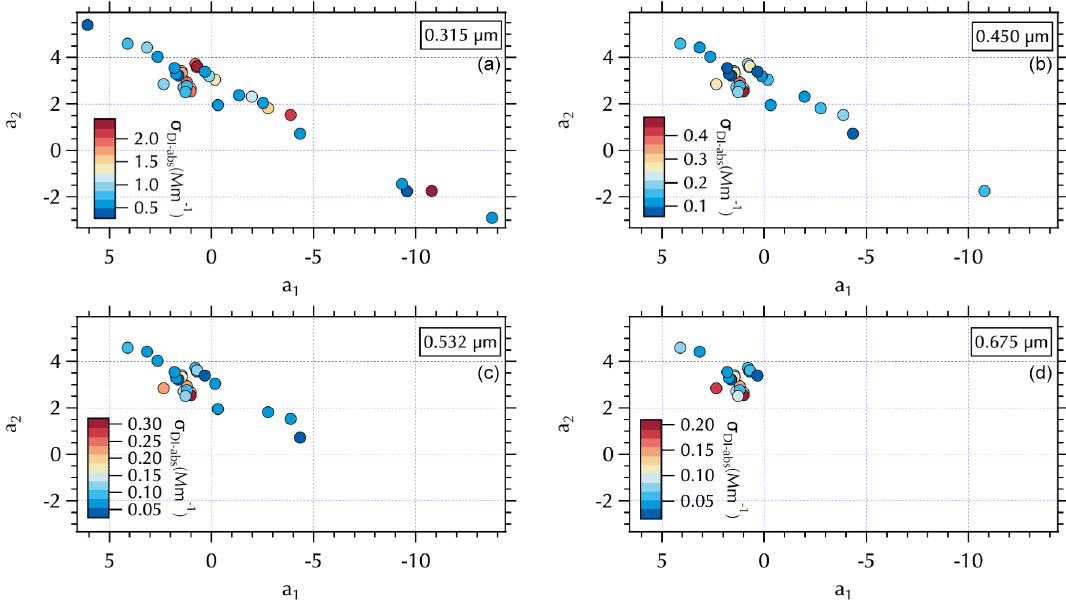
Figure 9. Maps of σ DI-abs (Mm − 1 ) in a 2 vs. a 1 space at 0.315µm (a) , 0.450µm (b) , 0.532µm (c) , and 0.675µm (d) .